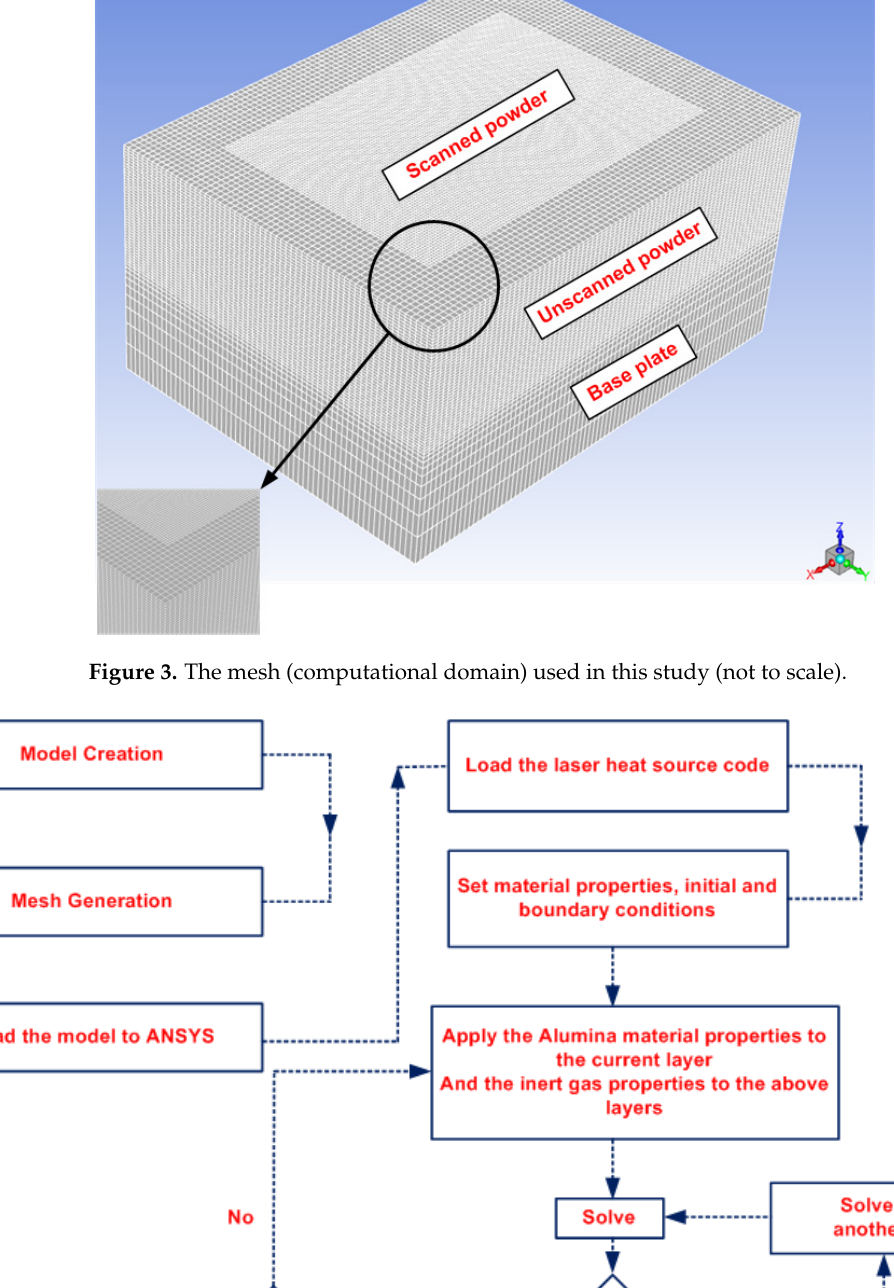
Table 3. Mesh density analysis .